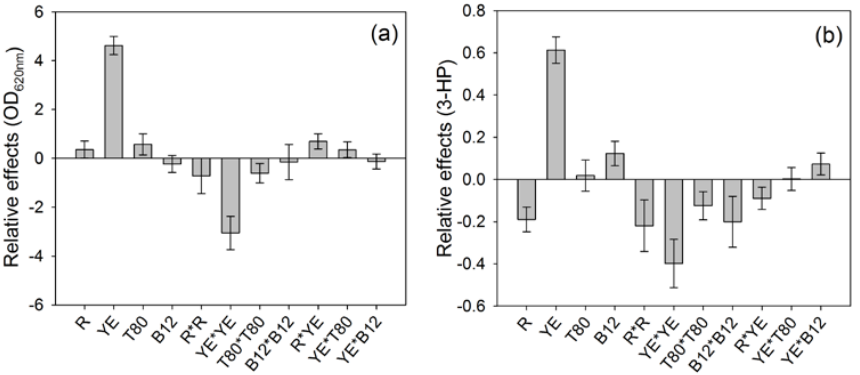
Figure 1. Relative and squared effects of the growth medium parameters on the final optical density at the end of the growth phase ( a ) and the 3-HP concentration ( b ) after the bioconversion of glycerol by L. reuteri.